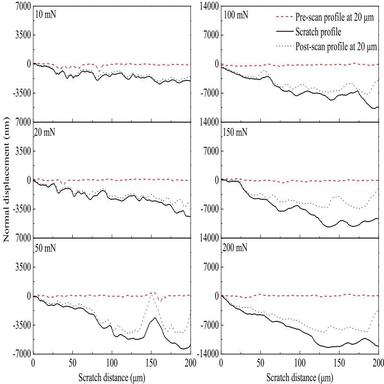
Pre-, formal- and post-scan scratch profiles under the LIL routine with different pre-designed loading levels: 10, 20, 50, 100, 150 and 200 mN.